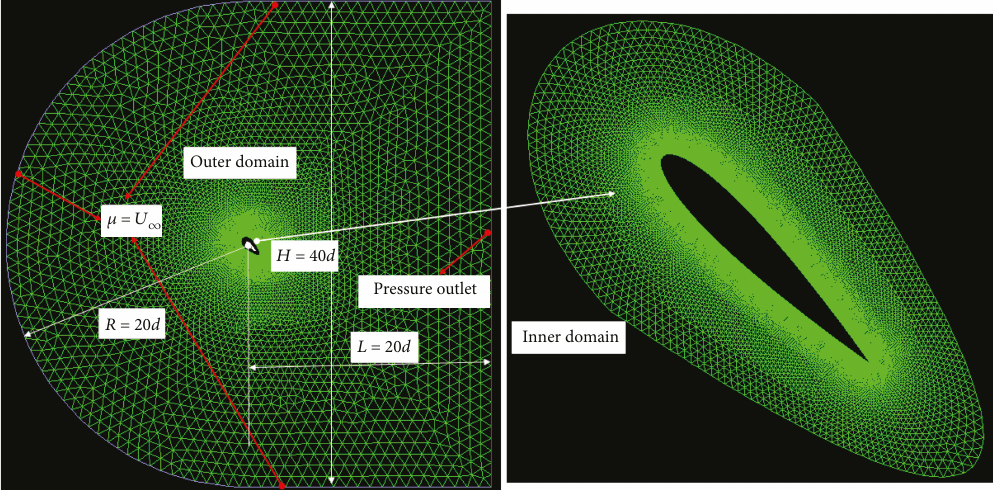
Figure 2: Schematic of the computational grid and boundary conditions.